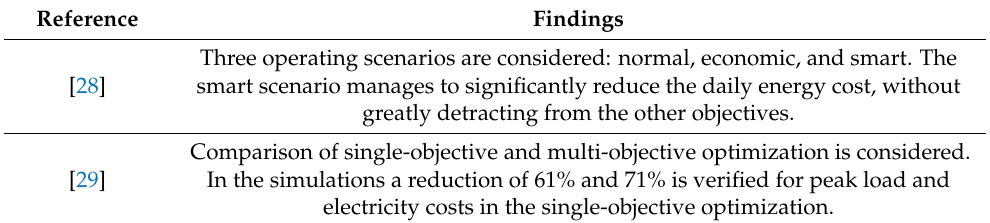
Table 9. Findings of selected papers associated with mixed-integer non-linear programming.